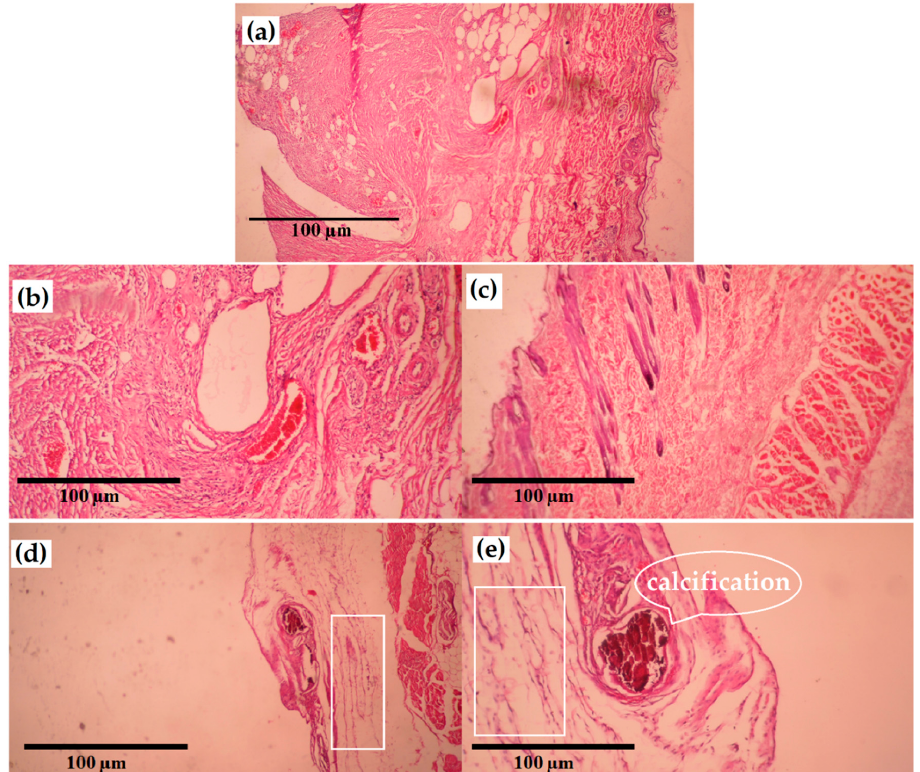
Figure 7. MTT assay on 3BG / GE / PCL samples as well as the results of cell viability determined by the cell counting method.